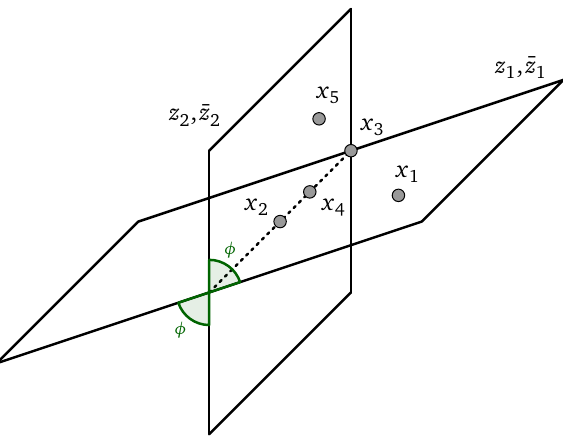
Figure 4 : Conformal frame for five